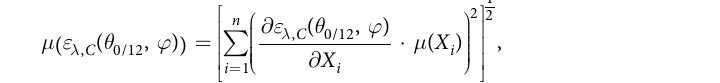
where X i are individual sources of uncertainty from equation (16), μ ( X i ) the absolute particular uncertainties of individual sources, ε θ ϕ ∂ the respective sensitivity coefficients and are the individual contributions of absolute particular uncertainty to total uncertainty of emissivity. Table 1. The absolute particular uncertainty of reflectance μ ( X i ) = μ ( ρ λ ∩ , C1 ( θ 12 , ϕ )) is established as the combined standard uncertainty of all particular sub-uncertainties μ ( Y j ) = μ ( ρ i ) caused by variables in equation (9). Each variable is loaded by the additional uncertainty that is computed as the combined standard uncertainty. Basic uncertainty sources of the measured quantities are identical and shown in Table 1. The other potential uncertainty sources as spectrometer and electronics without interreflections 32 , and sphere, sample and beam geometry and the interaction between them 4 are included in the repeatability of transmittance and reflectance measurement or neglected. The uncertainties and sub-uncertainties depend on the wavelength, and transmittance and reflectance values of the analyzed sample. Therefore, the uncertainty must be computed for the specific wavelength and specific sample. The same methodology is used to evaluate the uncertainty of both semitransparent and opaque bulk materials.